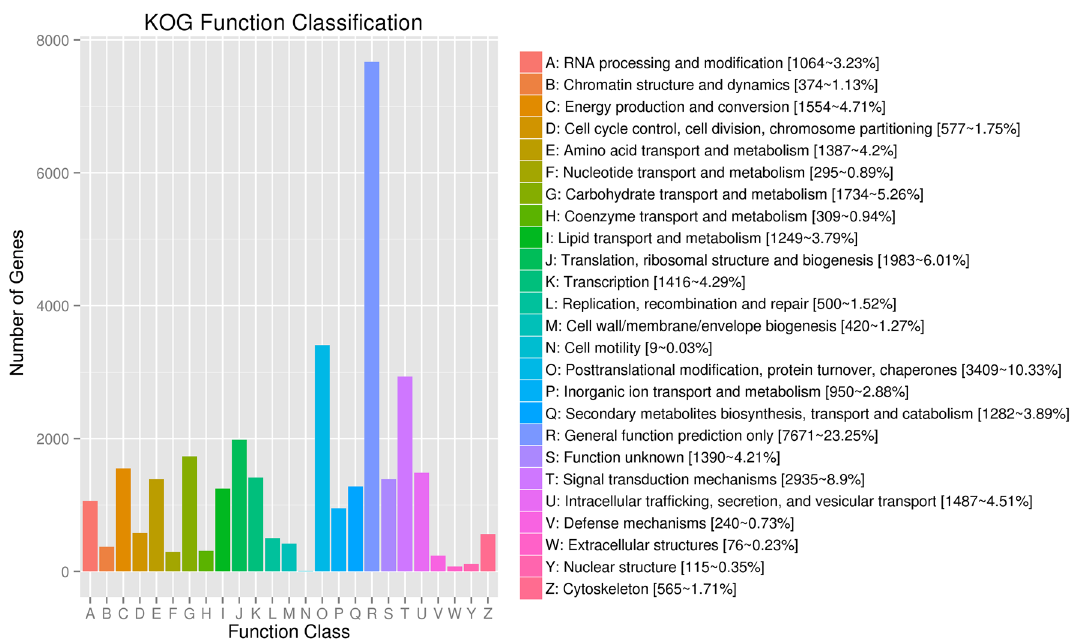
Figure 3. EuKaryotic clusters of Orthologous Groups (KOG) functional classification of unigenes. A total of 298, 81 annotated unigenes were found with significant homology in the KOG database (E-value ≤ 1.0 e −5 ). The x-axis indicates the names of the 25 KOG groups. The y-axis indicates the number of genes in 25 KOG categories. The numbers represent the count and percentage of unigenes in each category.